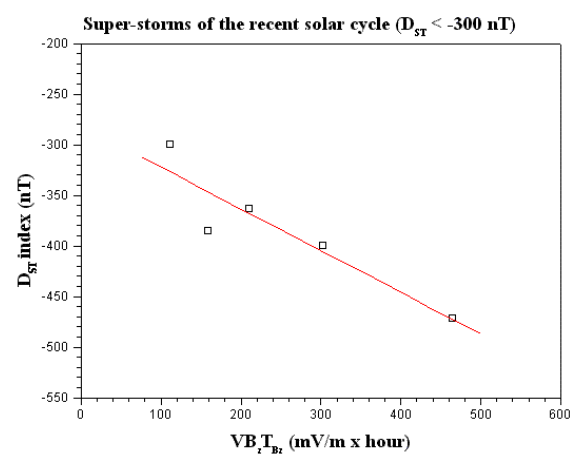
Fig. 3. Dependence of the strength of the geomagnetic storm in- tensity on the solar wind-magnetospheric coupling parameter and the duration in hours for which the interplanetary magnetic field remains